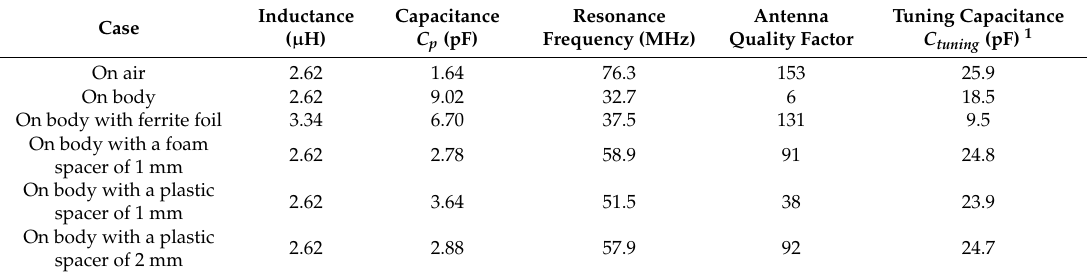
Table 4. The equivalent circuit of the antenna and tuning capacitance as a function of the